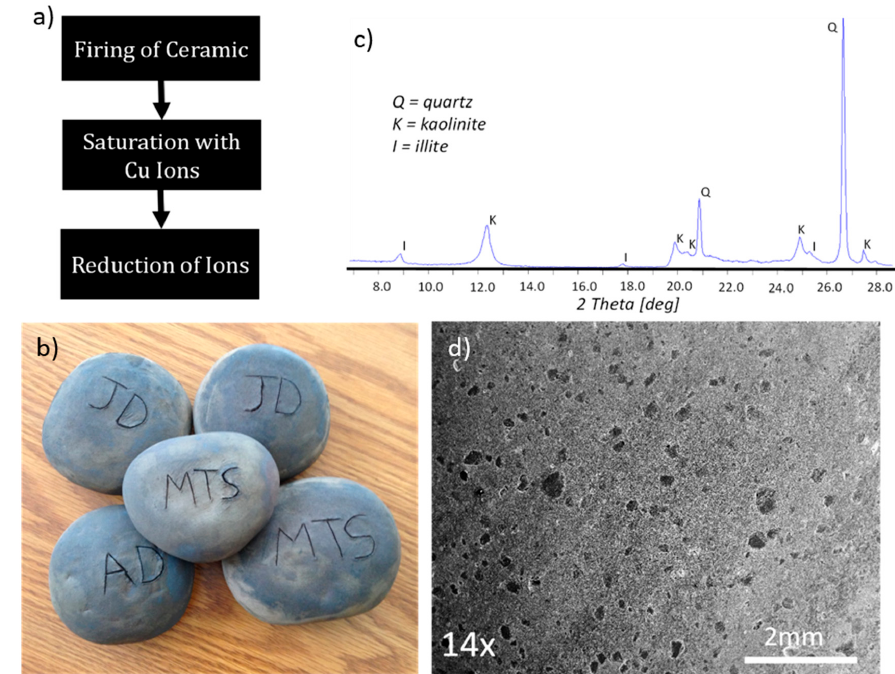
Figure 1. ( a ) schematic of the three steps in manufacturing antimicrobial ceramic stones; ( b ) ceramic stones; ( c ) x-ray diffraction pattern of the clay used in formulation of stones; ( d ) scanning electron micrograph of ceramic stone revealing porosity.